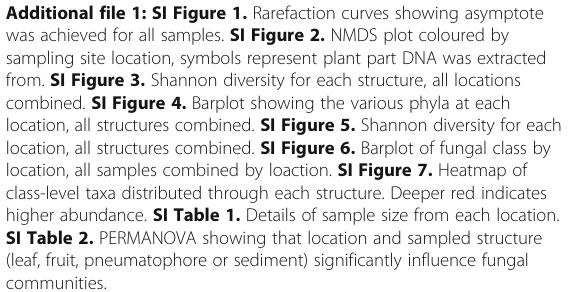
Additional file 1: SI Figure 1. Rarefaction curves showing asymptote was achieved for all samples. SI Figure 2. NMDS plot coloured by sampling site location, symbols represent plant part DNA was extracted from. SI Figure 3. Shannon diversity for each structure, all locations combined. SI Figure 4. Barplot showing the various phyla at each location, all structures combined. SI Figure 5. Shannon diversity for each location, all structures combined. SI Figure 6. Barplot of fungal class by location, all samples combined by loaction. SI Figure 7. Heatmap of class-level taxa distributed through each structure. Deeper red indicates higher abundance. SI Table 1. Details of sample size from each location. SI Table 2. PERMANOVA showing that location and sampled structure (leaf, fruit, pneumatophore or sediment) significantly influence fungal